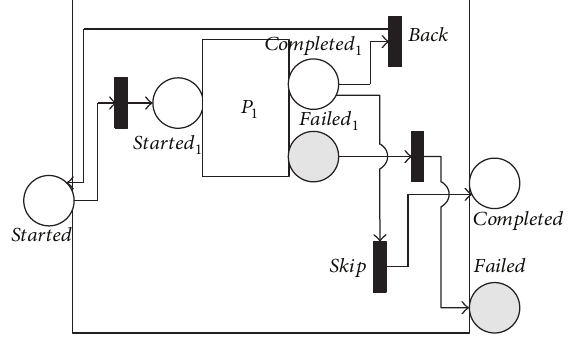
Figure 9: NMSPN model of the repeat-until